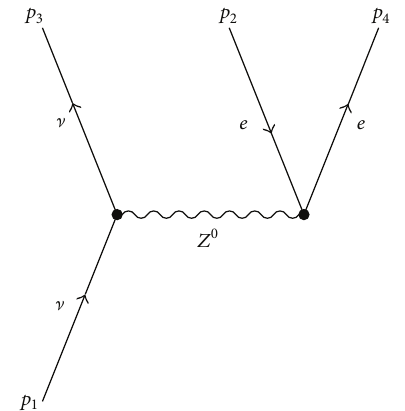
Figure 1: Conventions for tachyonic neutrino